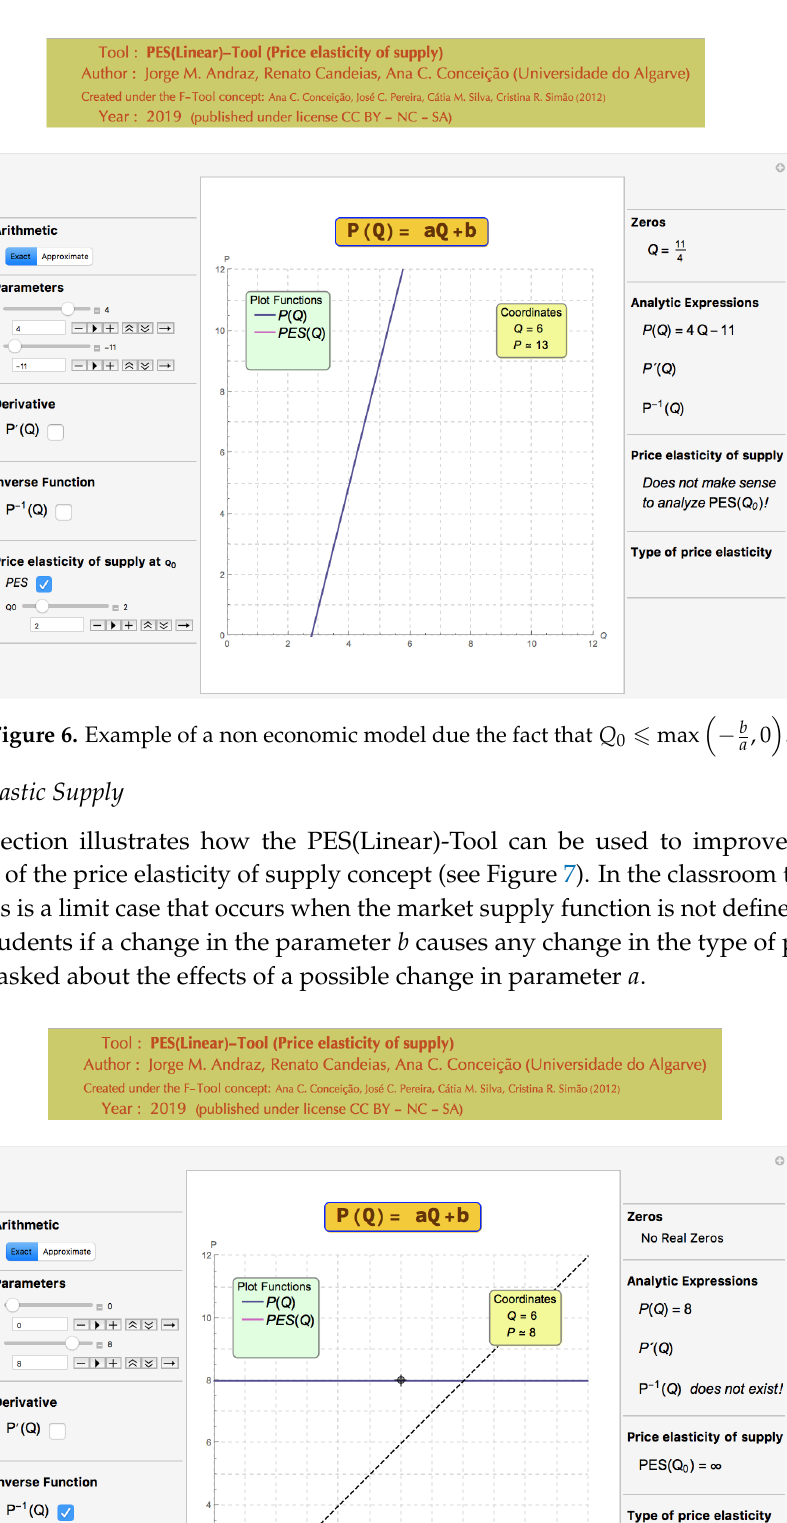
Figure 7. Example of a perfectly elastic